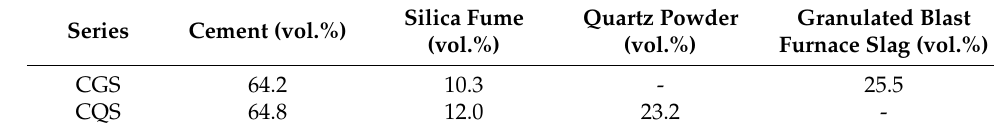
Table 3. Mixture proportions of the cementitious materials.